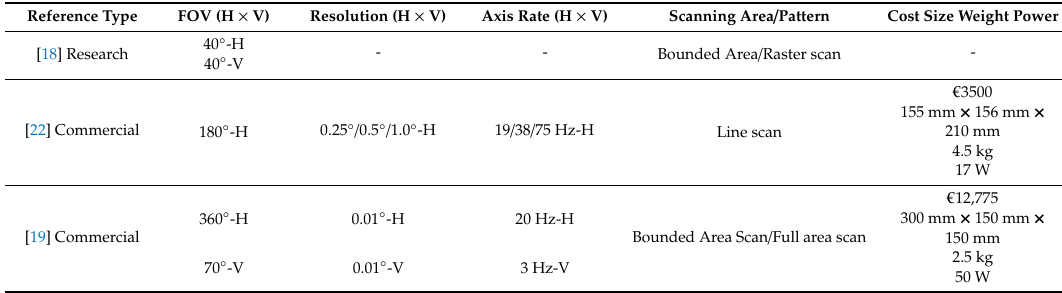
Table 1. Comparison of performance and size, weight, and power (SWaP) specifications for selected optomechanical scanning